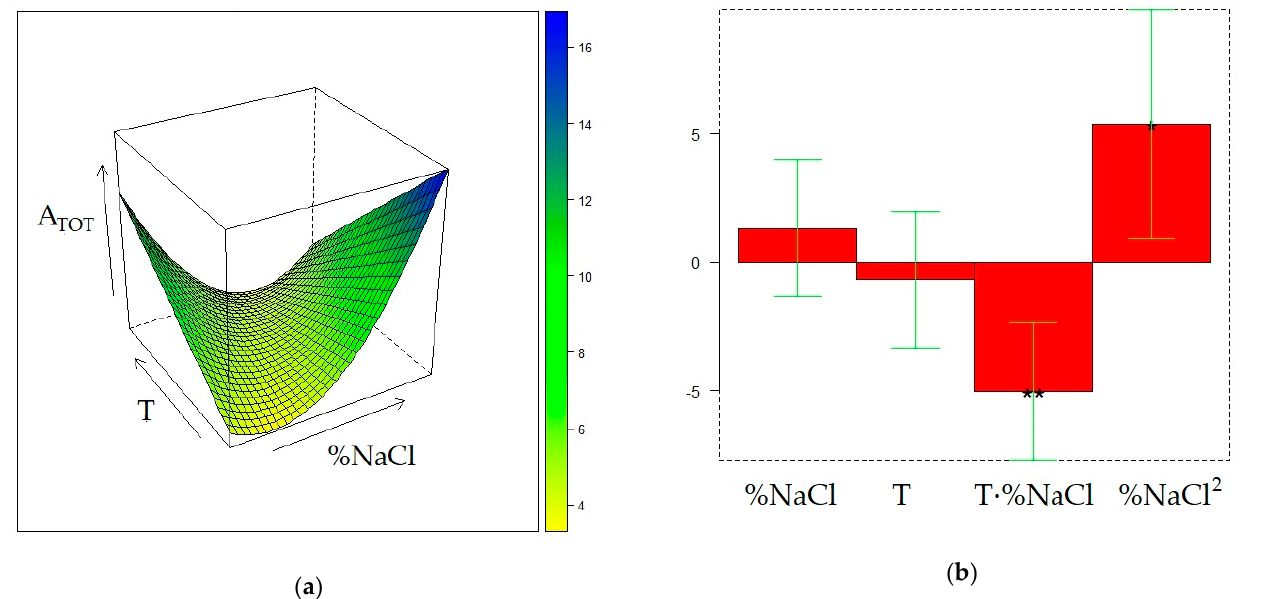
Figure 4. Optimization of HS-SPME profiling of wine volatiles extracted with the DVB/CAR/PDMS fiber: ( a ) response surface for the total area of the GC chromatogram (A TOT ); ( b ) coefficients of the surface model; p < 0.05 (*), p < 0.01(**).